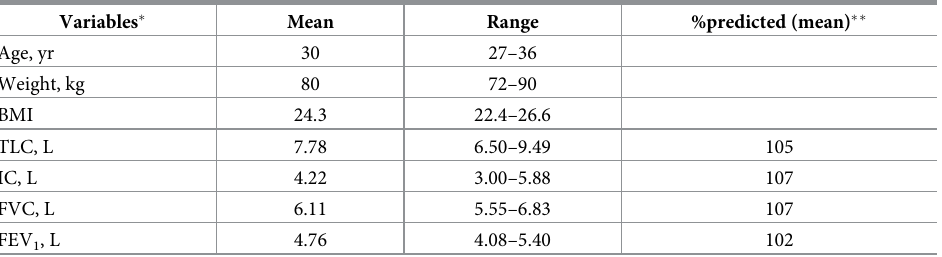
Table 1. Study participants: Mean and range of age, weight and spirometry values in ten healthy men.